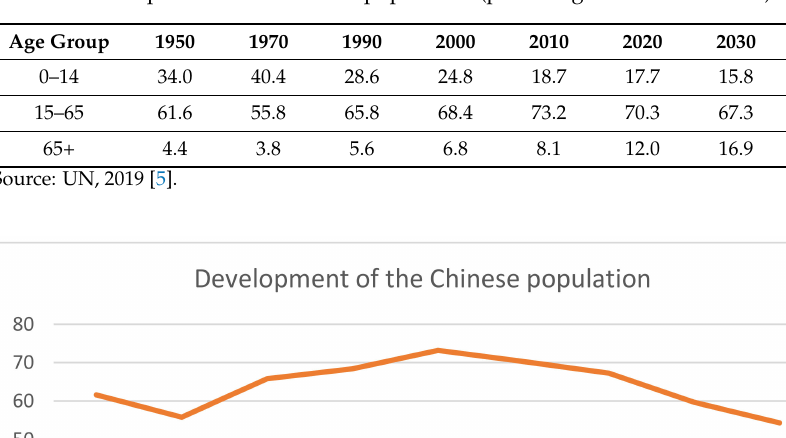
Table 3. Development of the Chinese population (percentage—middle variant).